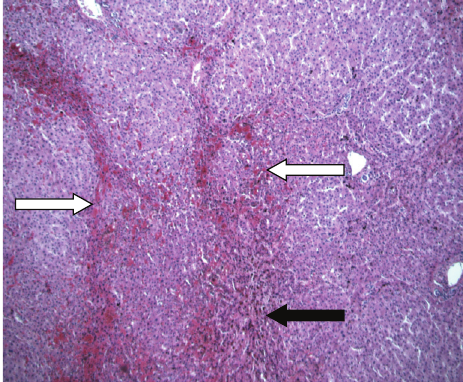
Figure 2: Overview of the intra-operatively obtained liver specimen (Case 2) in which the liver has a disturbed architecture with nodular appearance of liver parenchyma (white arrows) characteristic of nodular regenerative hyperplasia. Areas with sinusoidal congestion are also present (black arrow). Hematoxylin and eosin, original magnification 50x.